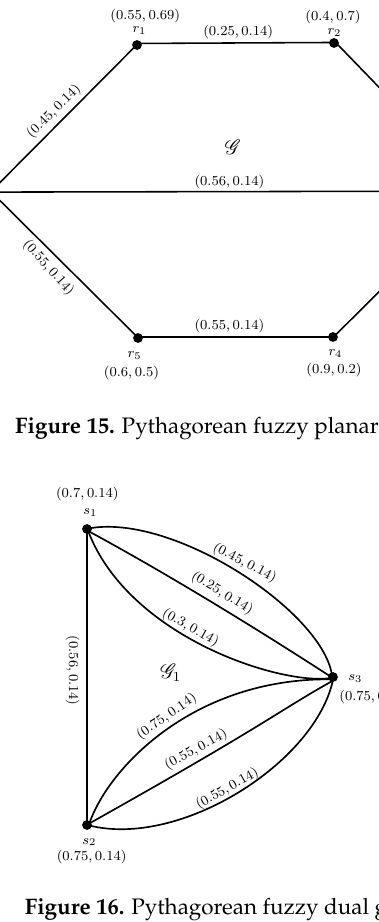
Figure 16. Pythagorean fuzzy dual graph. Figure 6.5: Pythagorean fuzzy dual graph